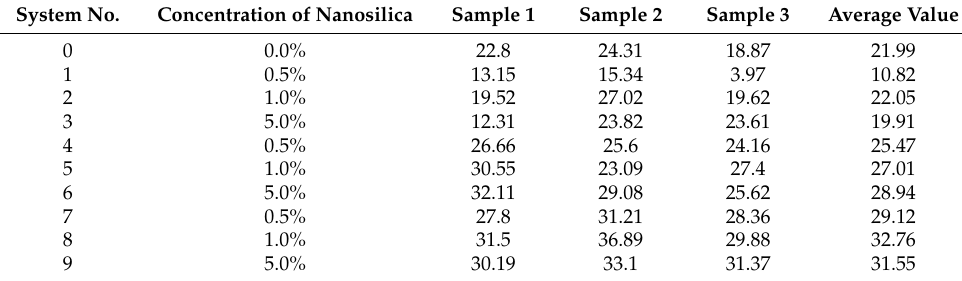
Table 2. Results of compressive strength of samples seasoned for 7 days (MPa).